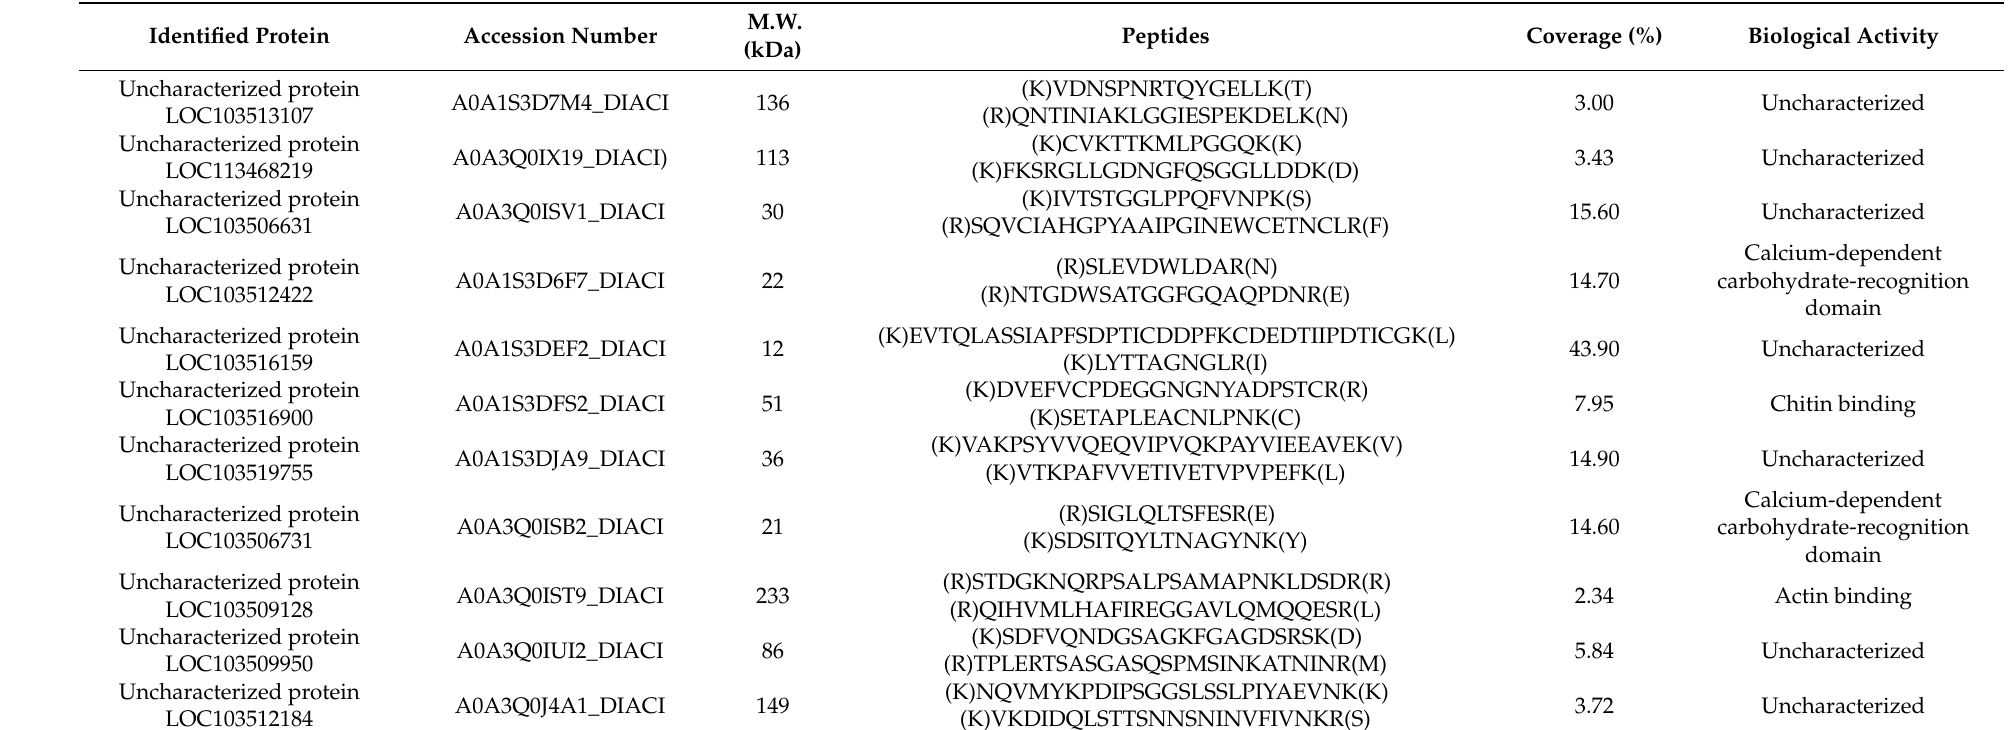
Table 1. Proteins identified from Diaphorina citri